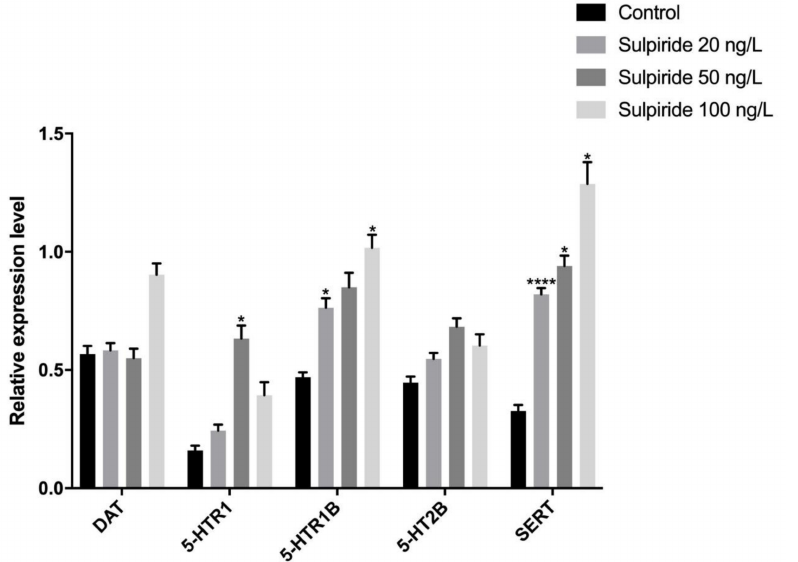
Figure 5. Sulpiride exposure for 14 days induced changes in protein expression levels of functional molecules of DA and 5-HT neurotransmitter systems in octopus brain tissue. Note: * compared with the control group, p < 0.05; **** compared with the control group, p < 0.0001; n = 5. DAT, 5-HTR1, 5-HTR1B, 5-HTR2B, and SERT expression levels were abnormal in the octopus brain tissues after 14 days of clozapine exposure ( p < 0.05). The expressions of DAT, 5-HTR1B, 5-HTR2B, and SERT were upregulated in the 20 ng/L clozapine exposure group ( p > 0.05). The expressions of 5-HTR1, 5-HTR2B, and SERT were upregulated ( p > 0.05) and the expression of 5-HTR1B was upregulated ( p < 0.05) in the 50 ng/L group. DAT expression was decrease significantly ( p < 0.05) after the 100 ng/L treatment (Figure